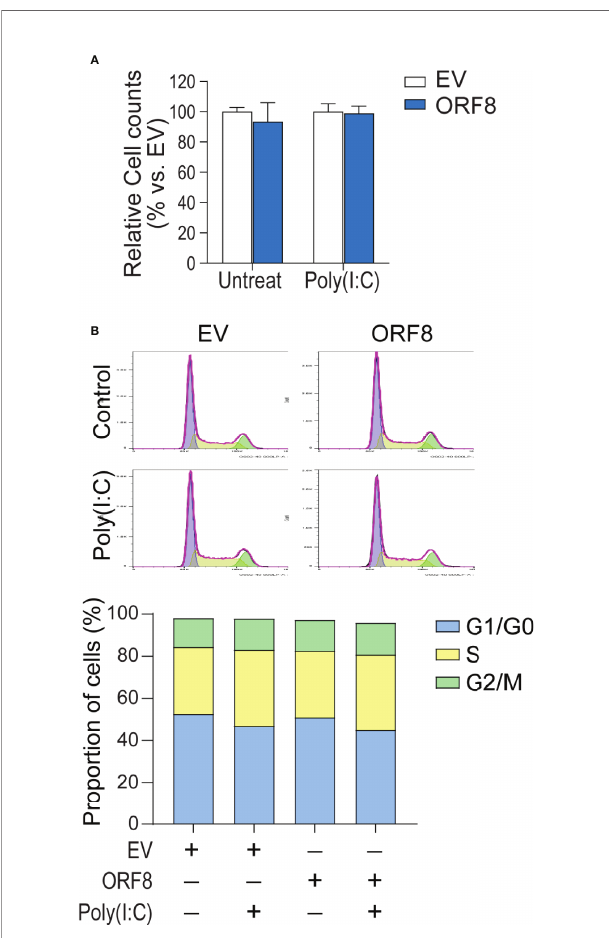
FIGURE 3 | Expression of ORF8 SARS-CoV-2 does not affect lung epithelial cell proliferation or cell cycle progression. Human A549 lung epithelial cells were transfected with pEGFP-N1 (empty vector, EV) or pEGFP-ORF8 SARS-CoV-2 and treated with or without poly (I:C). At 24 hours post-transfection, cells were processed for in vitro proliferation assay (A) and fl ow cytometry-based cell cycle analysis (B) . n = 3 for each